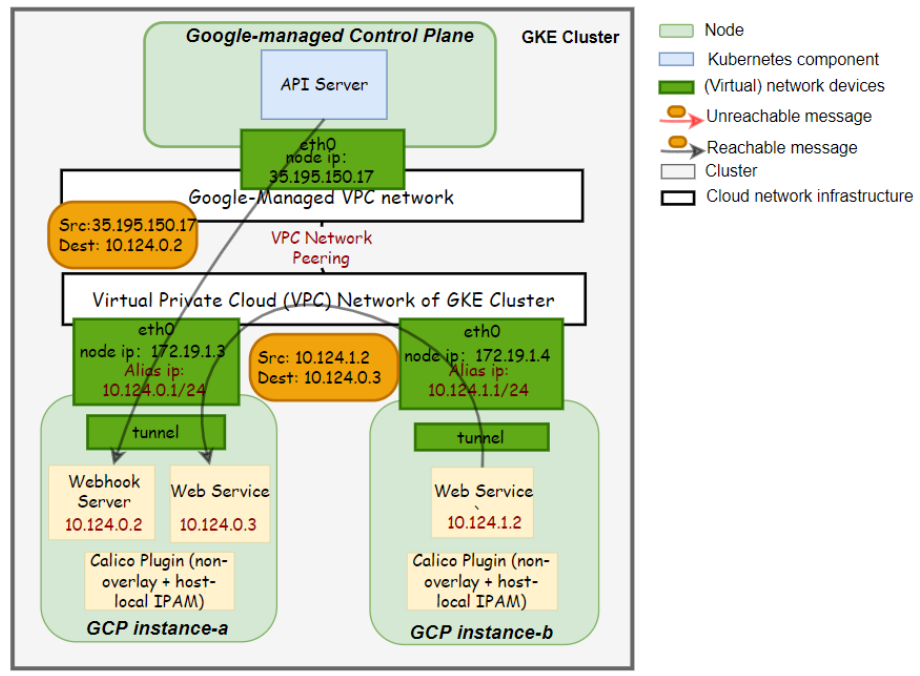
Figure 6. Pod connectivity in a GKE cluster with the configured Calico